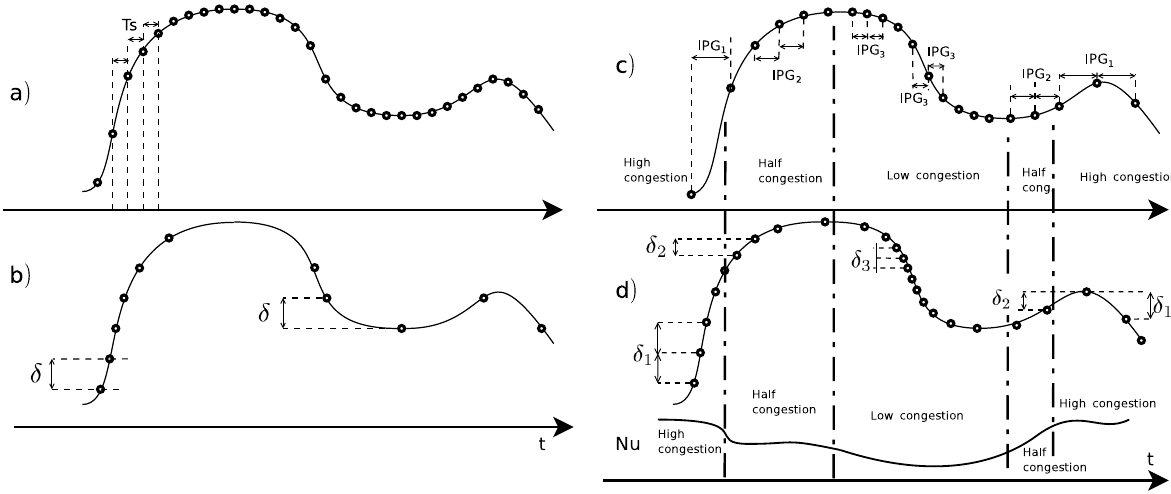
Figure 2. Points representing data transmission events for diverse transmission